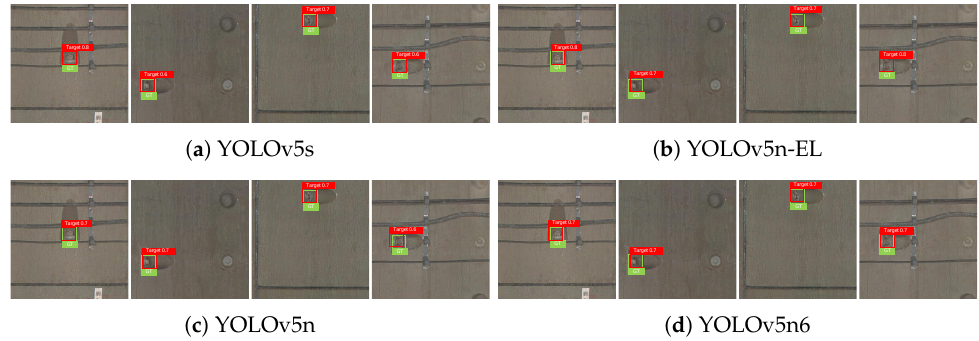
Figure 9. Examples of detection results without color enhancement.